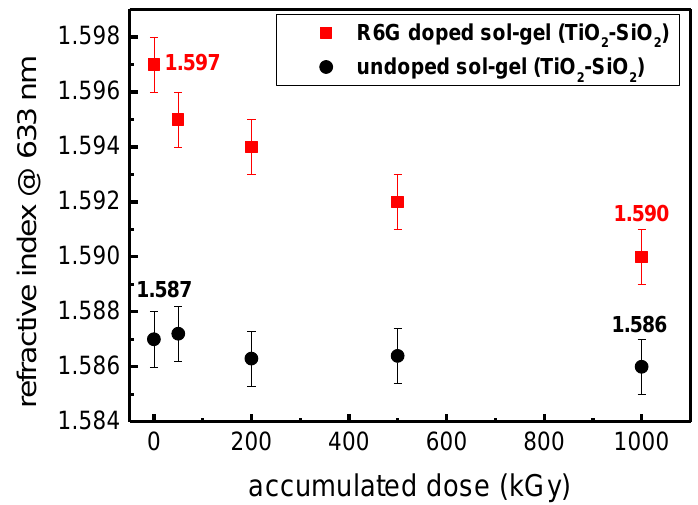
Figure 8. Refractive index (633 nm) evolution for different accumulated doses of: 0 kGy (pristine sample), 50 kGy, 200 kGy, 500 kGy and 1 MGy. The investigated films are a R6G doped sol-gel layer (red square) and an undoped TiO 2 -SiO 2 film (black line). The films were deposited on a borofloat 33 substrate.